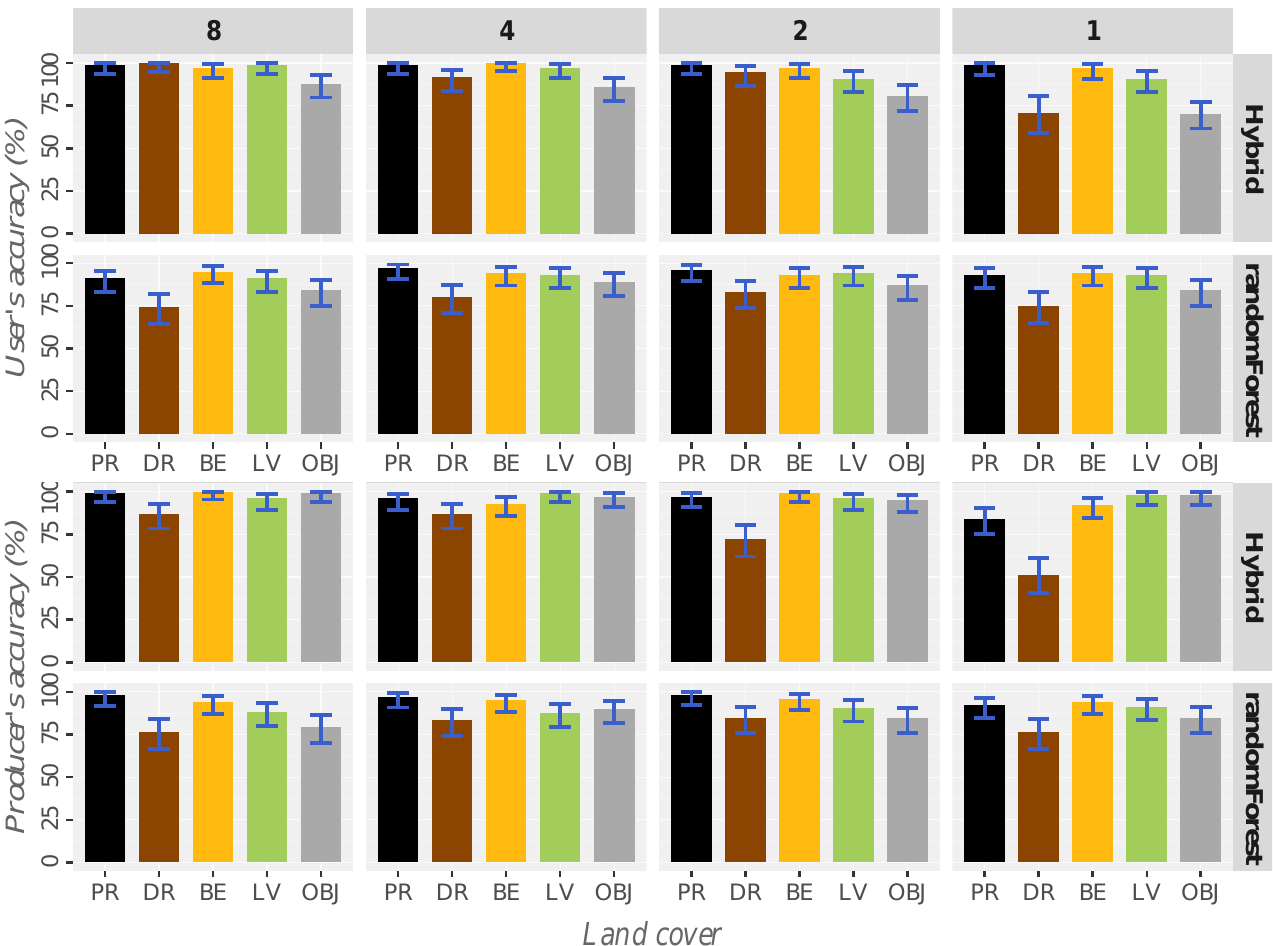
Figure 10. Hybrid vs. RF: User’s and producer’s accuracy (%) by land cover for point clouds with densities of 8 (first column), 4 (second column), 2 (third column) and 1 (last column) point/m 2